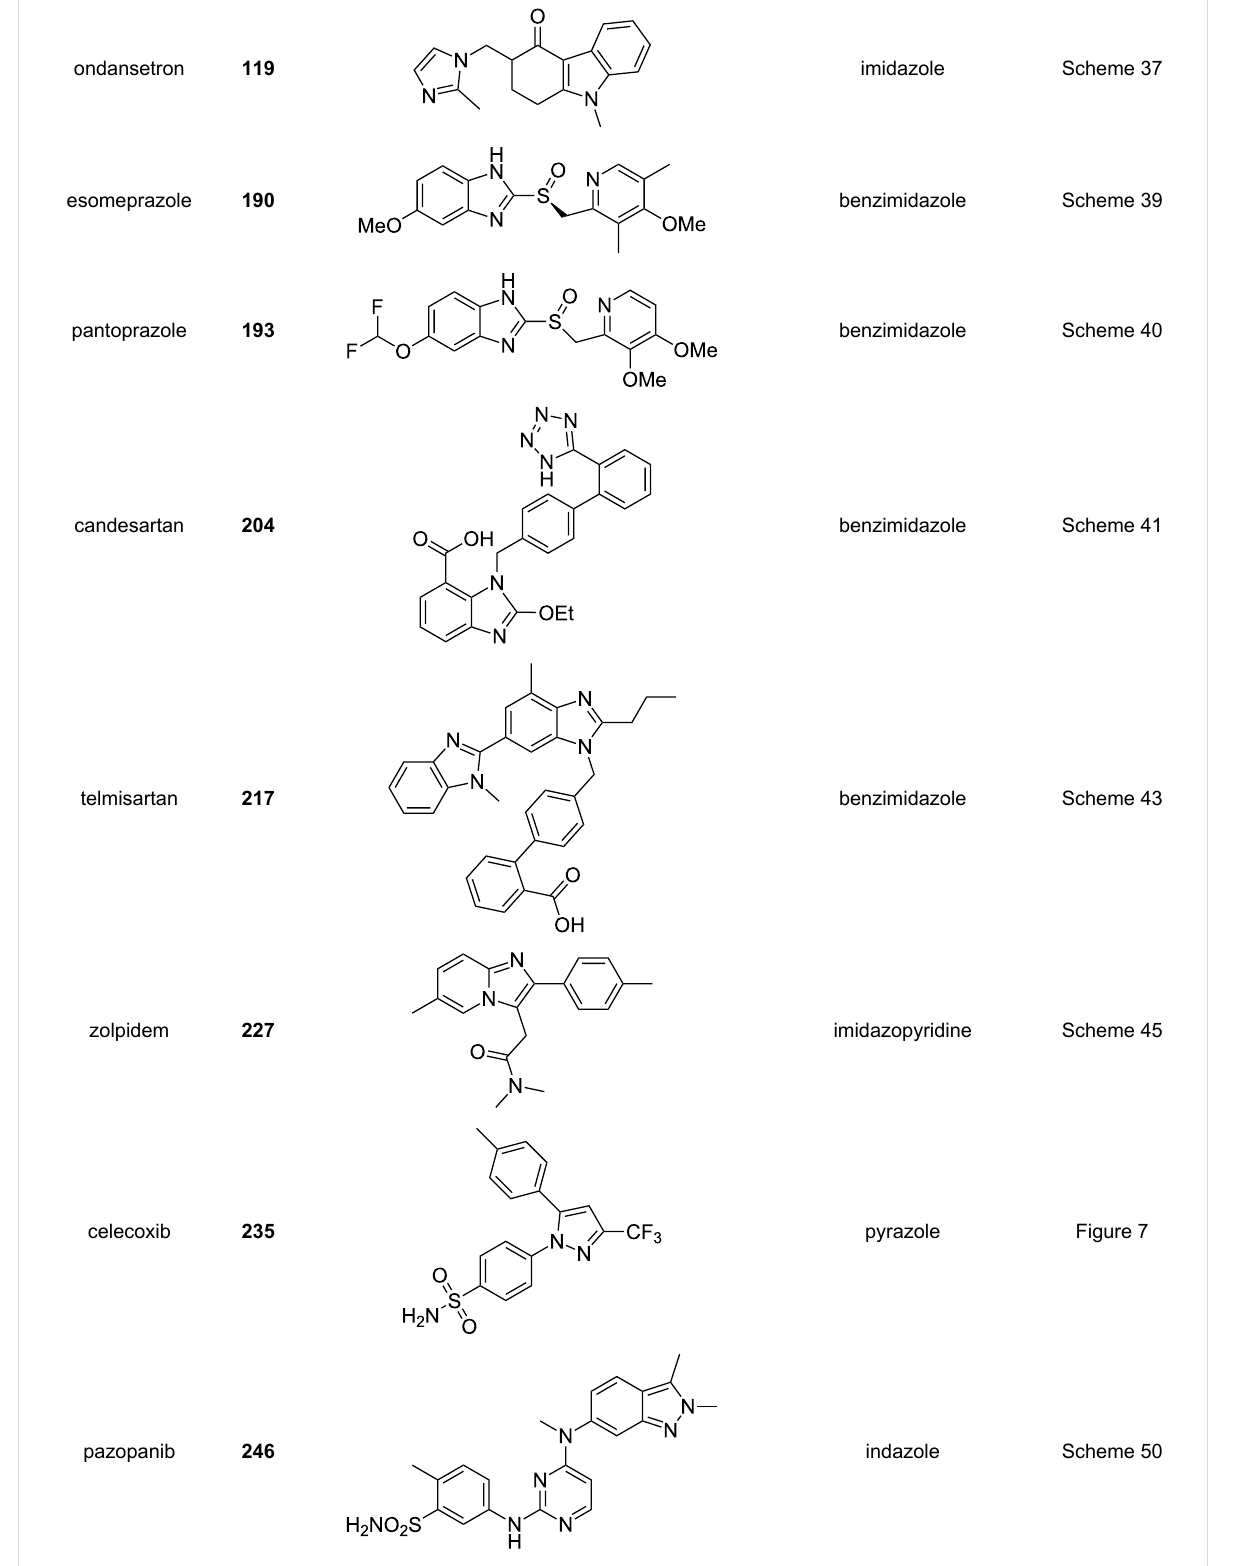
Table 1: Heterocylic structures discussed in this review. (continued)